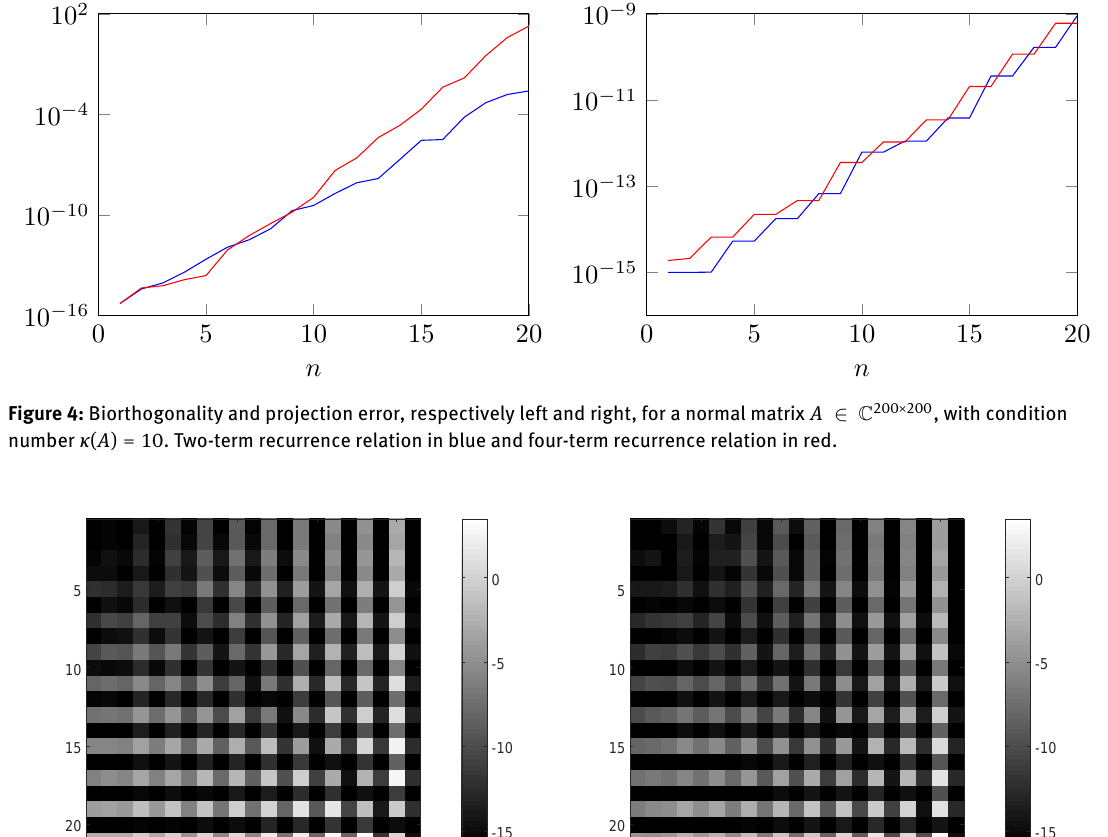
Figure 5: Magnitude (base 10) of the elements appearing in the moment matrix W H relation on the left and right, respectively. Bases V , W are constructed for a normal matrix A with κ ( A ) = 10